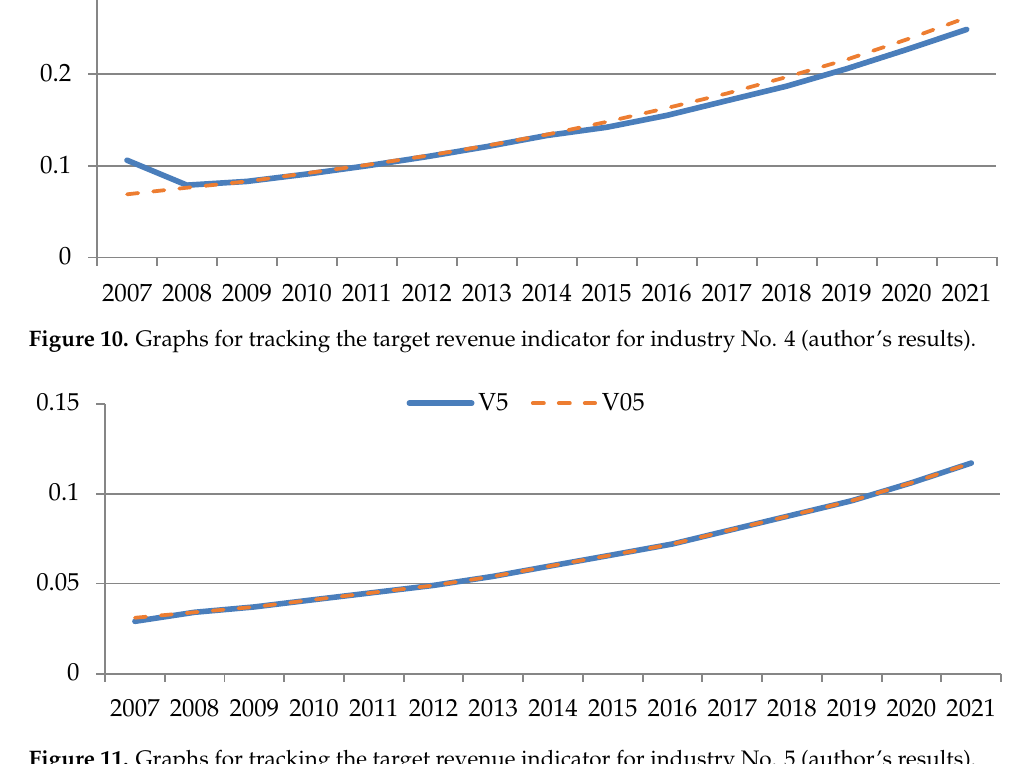
Figure 12. Graphs for tracking the target revenue indicator for industry No. 6 (author’s results). The efficiency indicator takes a value from 0 to 1. The closer it is to 1, the more effi ‐ cient the enterprise is, and vice versa, if it is closer to 0, then it is less efficient. To solve the problem, the parameter was set equal to 0.5, eff = 0.5 , since it is the average value of the efficiency indicator. The results of the efficiency assessment of small business sector activities of a single ‐ industry town are presented in Table 6. Table 6. Efficiency assessment values (author’s results). Sector